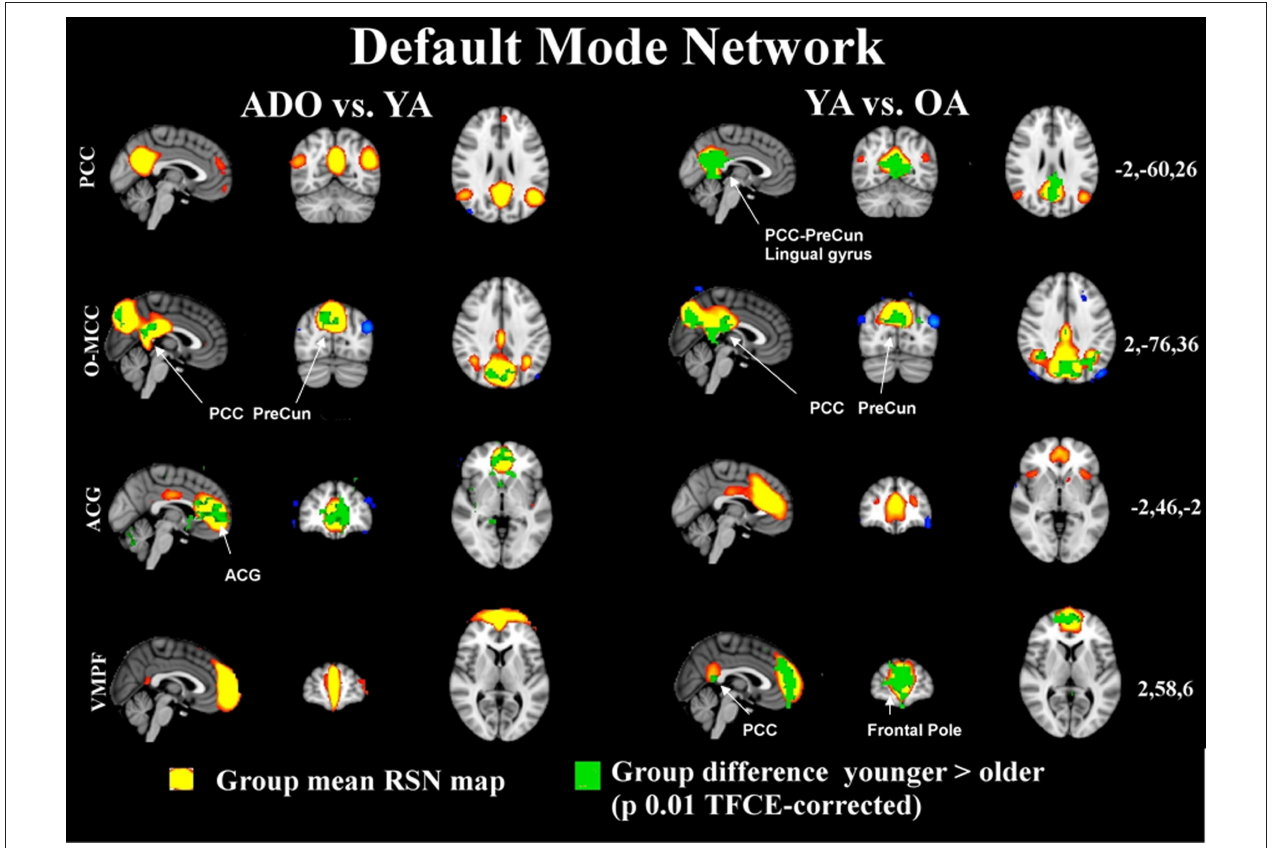
differences between the groups (left ADO vs. YA, on right YA vs. OA) after dual regression. Significant difference areas are named and pointed with white arrows. PCC = posterior cingulate gyrus, PreCun = precuneous, ACG = anterior cingulate